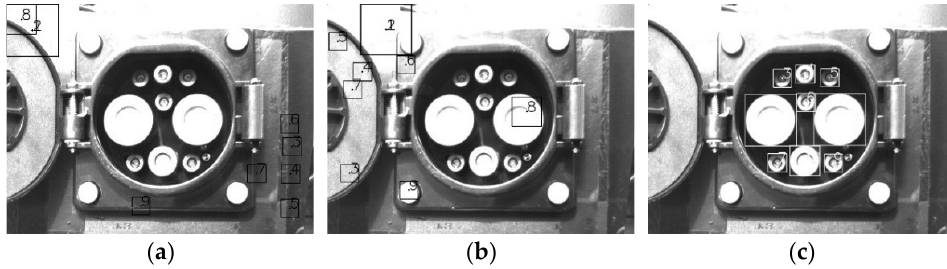
Figure 11. The recognition effect of the template matching method. ( a ) Gradient map template matching before improvement. ( b ) Gray map template matching before improvement. ( c ) Template matching method after improvement.